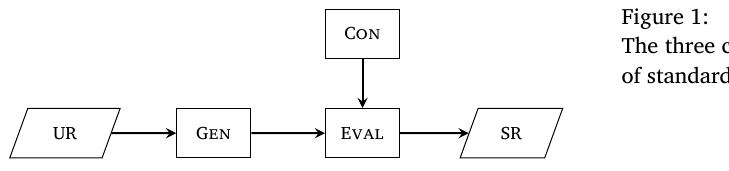
Figure 1: The three components of standard